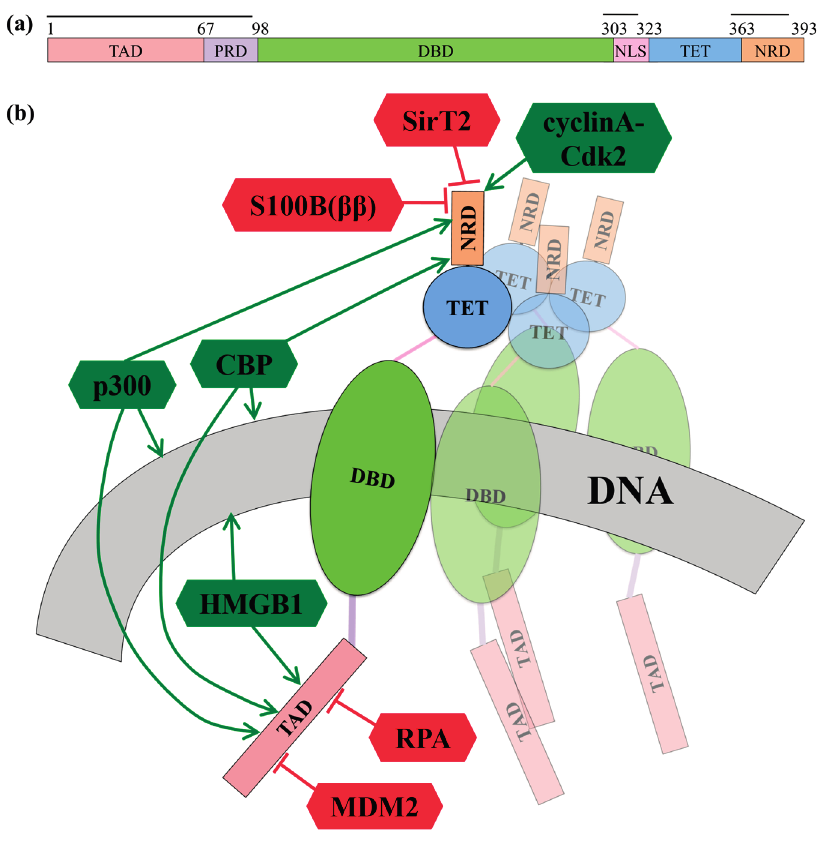
Figure 4. p53 domains and interactions. ( a ) Primary sequence of p53, colored according to domains. Black lines are drawn over domains that are intrinsically disordered in the monomer; and ( b ) Schematic of interactions between p53 and the binding partners discussed in this review. A full p53 tetramer is shown bound to DNA. Interactions are shown along a single monomer; the remaining monomers are faded. Green and pointed arrows indicate interactions that promote transcription activity by p53; red and blocked arrows indicate interactions that repress transcription activity by